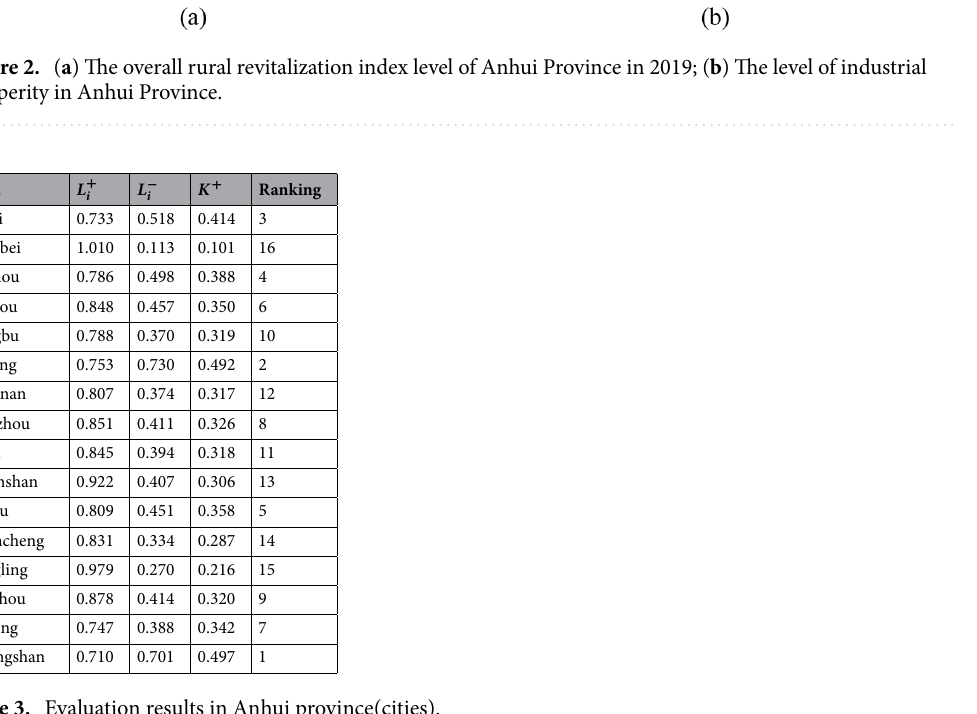
Table 3. Evaluation results in Anhui